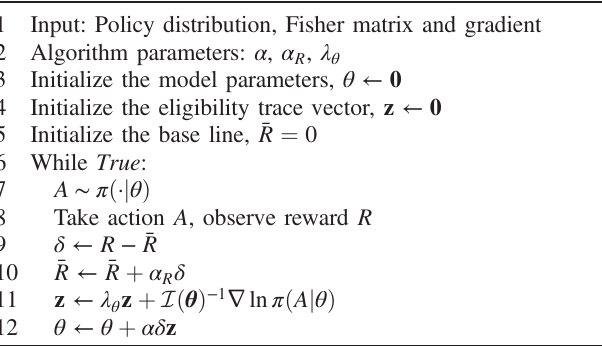
Algorithm 1. Minimum Policy Gradient Learning. 1 Input: Policy distribution, Fisher matrix and gradient 2 Algorithm parameters: α , α R , λ